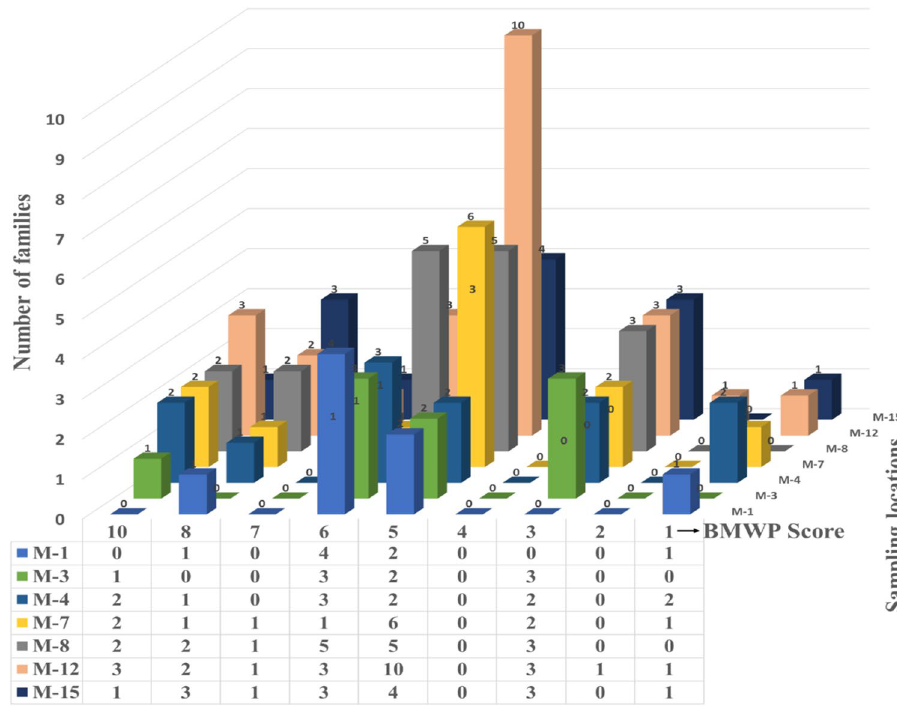
Fig. 4 Graphical representation of number of families encoun- tered at sampling